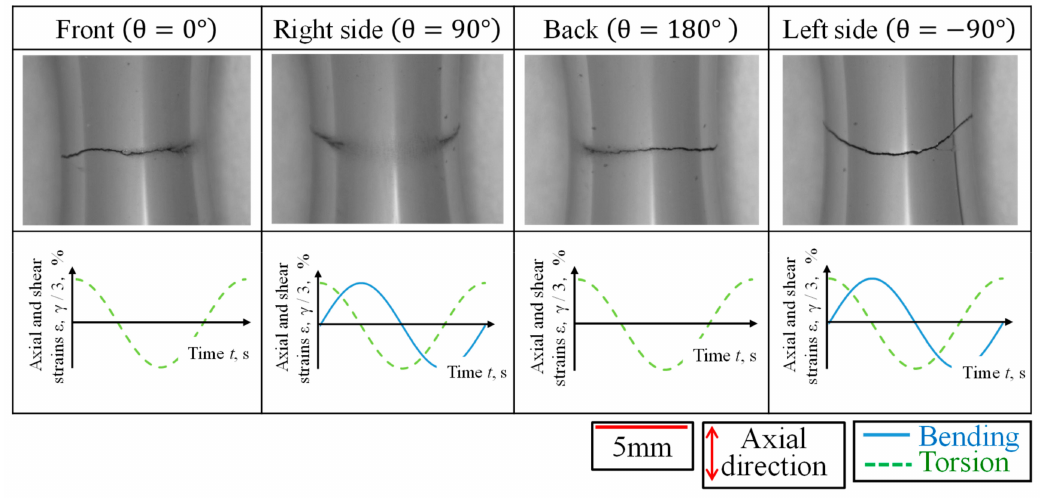
Figure 13. Surface observation results for the specimen after the CT test.